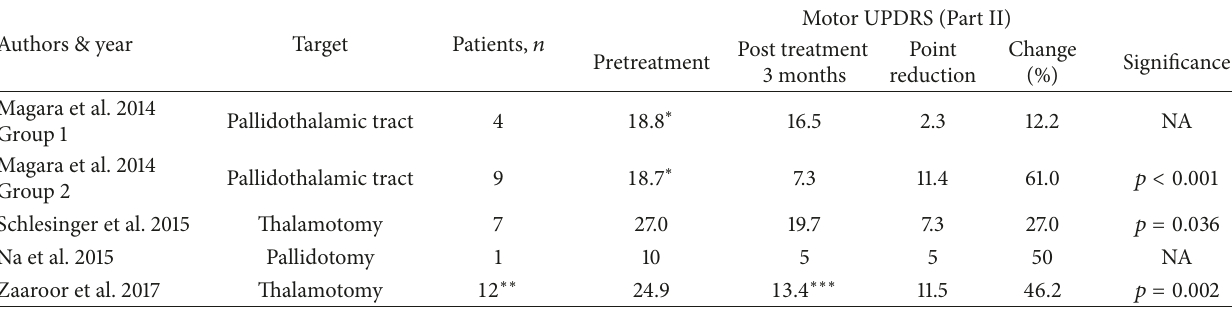
Table 2: Treatment outcomes of Parkinson’s disease patients that underwent MRgFUS